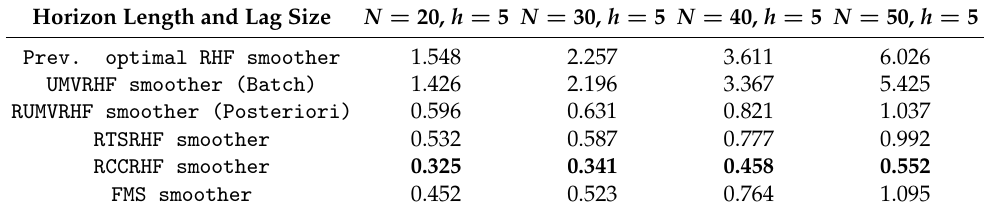
Table 4. Average computation time of RHF smoothers ( msec ). Horizon Length and Lag Size